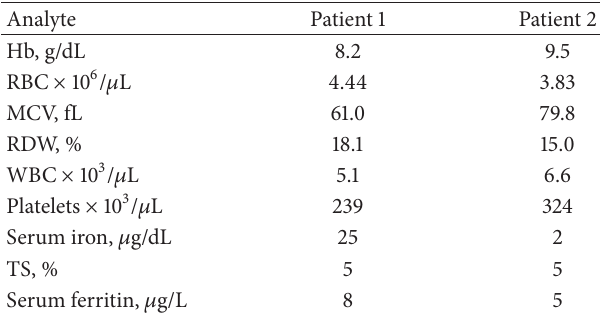
Table 1: Laboratory results in two women at diagnosis of iron deficiency 1 .